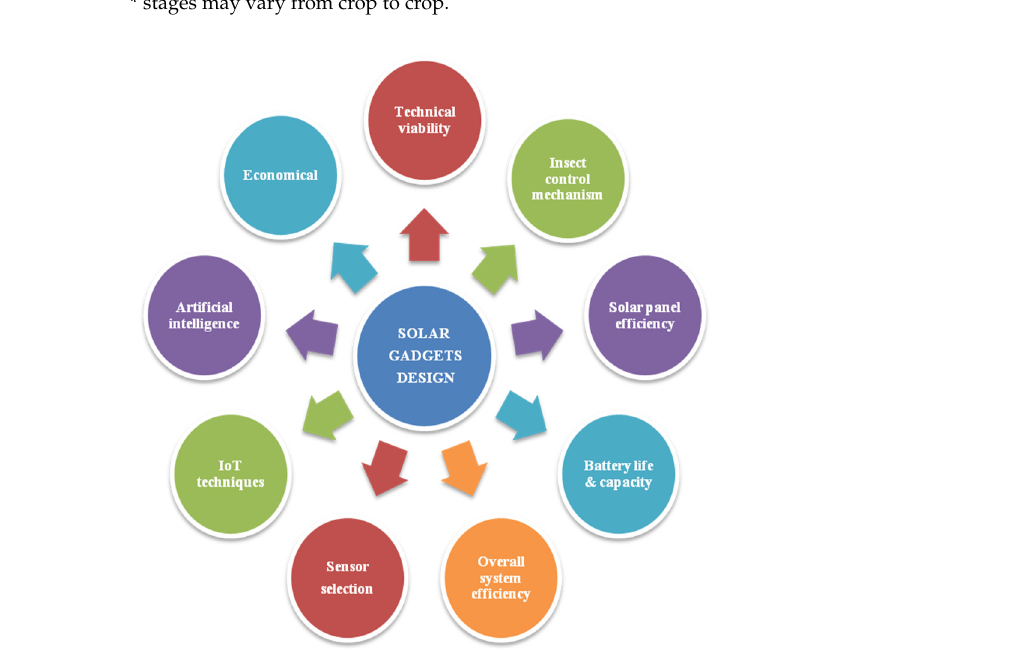
Figure 6. Thrust areas for PV-powered plant protection equipment. Figure 6. An integrated approach: solar-powered drone for bird scaring and spraying operations.